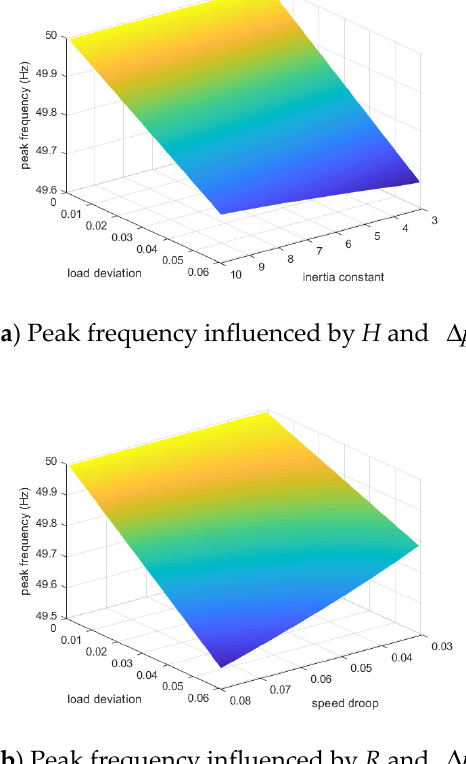
Figure 8. Composite influence on the peak frequency.